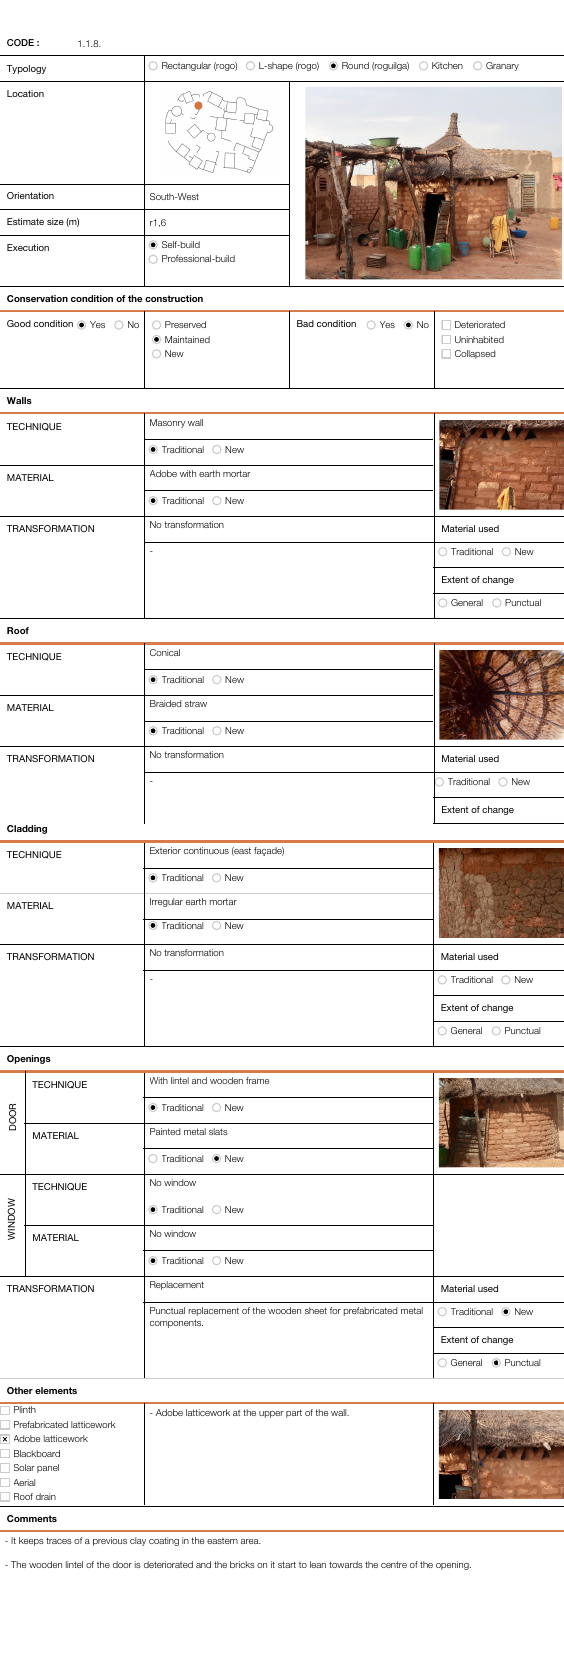
Figure 5. Fiche C: Material and constructive